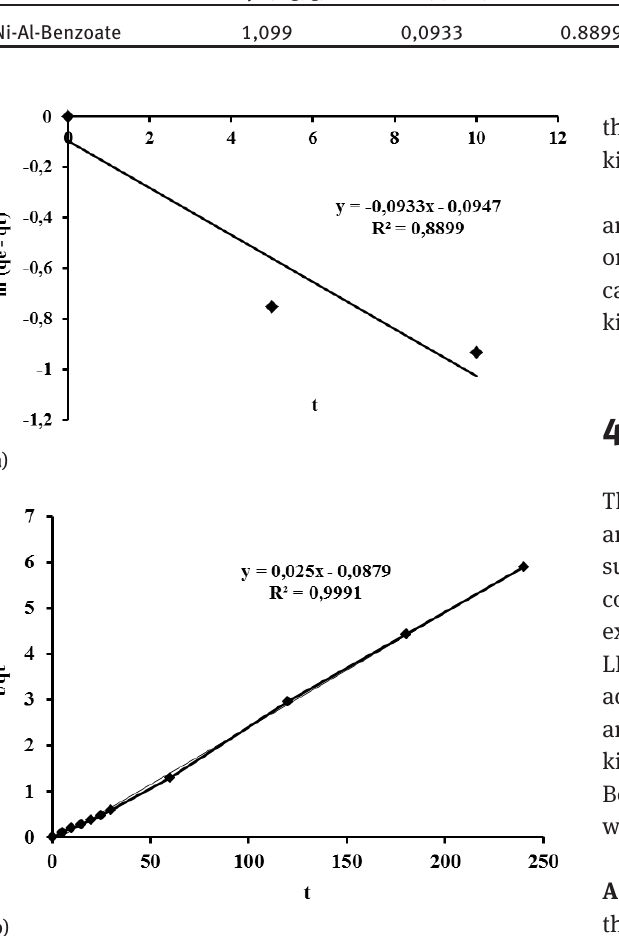
Table 1: Kinetics parameters for amoxicillin adsorption on the Ni-Al-Benzoate. LDH Pseudo first